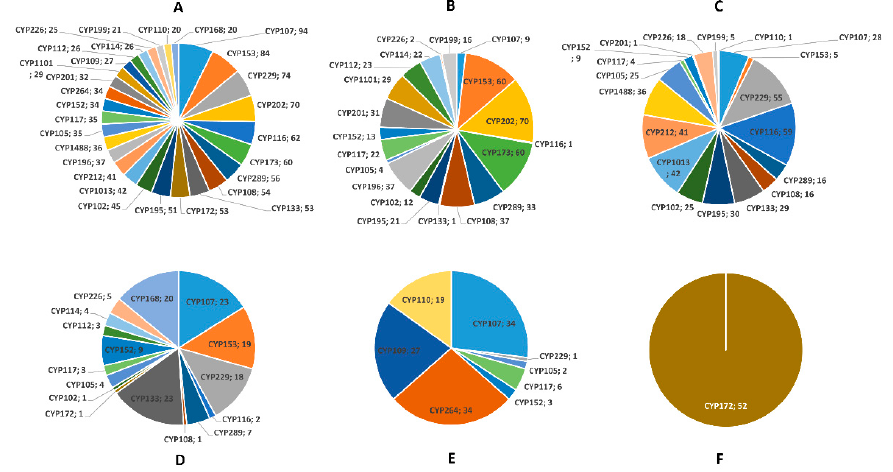
Figure 2. Comparative analysis of P450 families in proteobacterial species. ( A ) Complete set of P450 families in five different classes of proteobacterial species. P450 family analysis in alphaproteobacterial species ( B ), betaproteobacterial species ( C ), gammaproteobacterial species ( D ), deltaproteobacterial species ( E ), and epsilonproteobacterial species ( F ). The P450 families with ≥ 20 members are presented in the figure. The P450 family name and number of P450s are shown in the figure. Detailed information on P450 families and subfamilies is presented in Table S2.